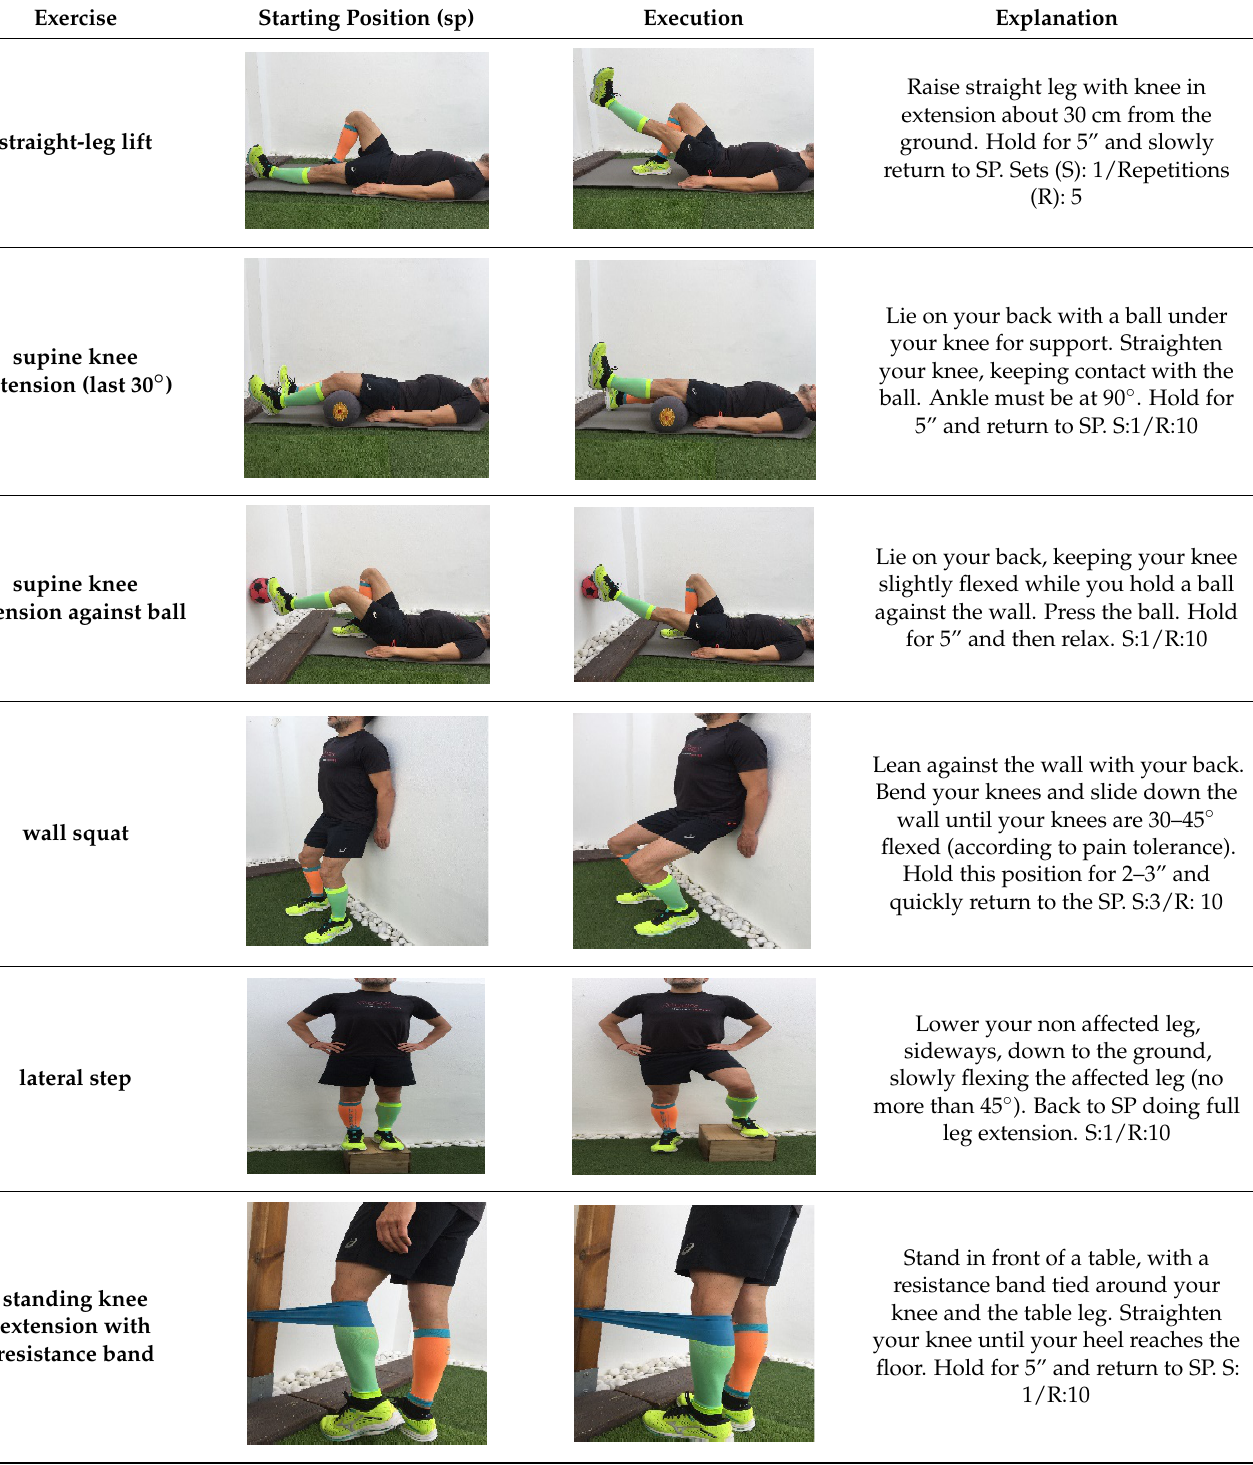
Table 1. Training program. Patellofemoral pain syndrome basic plus stretches.